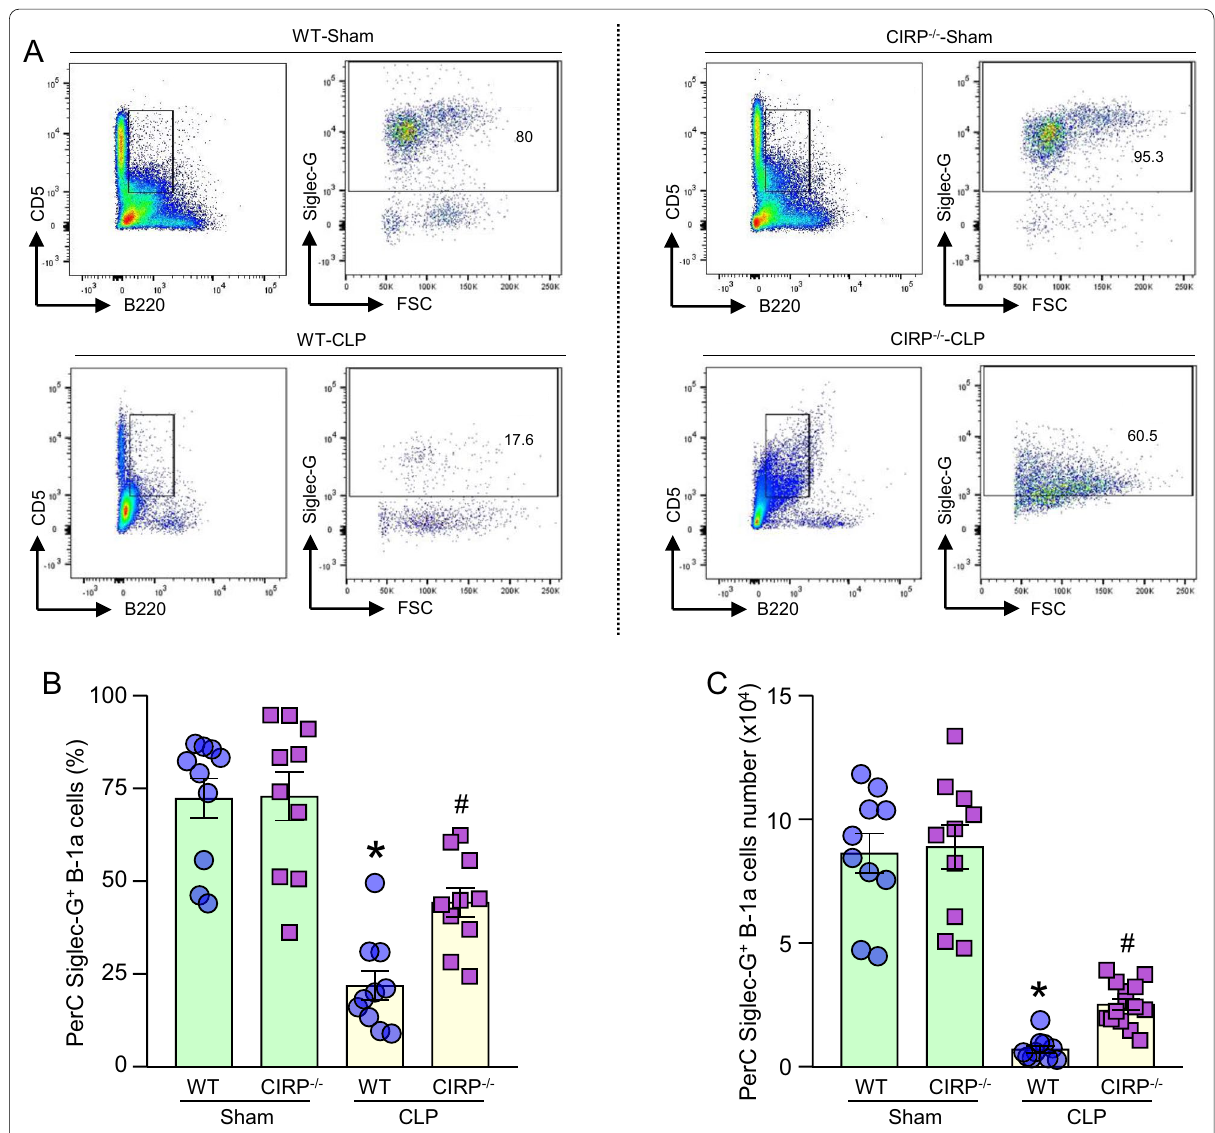
Fig. 2 Expression of Siglec-G by B-1a cells is dramatically reduced after sepsis, but its expression is protected in CIRP − / − mice after sepsis. WT and CIRP − / − mice were randomly assigned to sham or CLP groups. 20 h after CLP, peritoneal lavage samples were collected for analysis. A Representative dot blots of the gating strategy of Siglec-G expression on B-1a cells of sham and CLP mice are shown. B, C Status of Siglec-G expression by B-1a cells in terms of frequency (%) and number after surgery are shown. Data are expressed as means The groups were compared by one-way ANOVA and Student–Newman–Keuls (SNK) method (*p < 0.05 vs. WT sham and # p < 0.05 vs. WT CLP